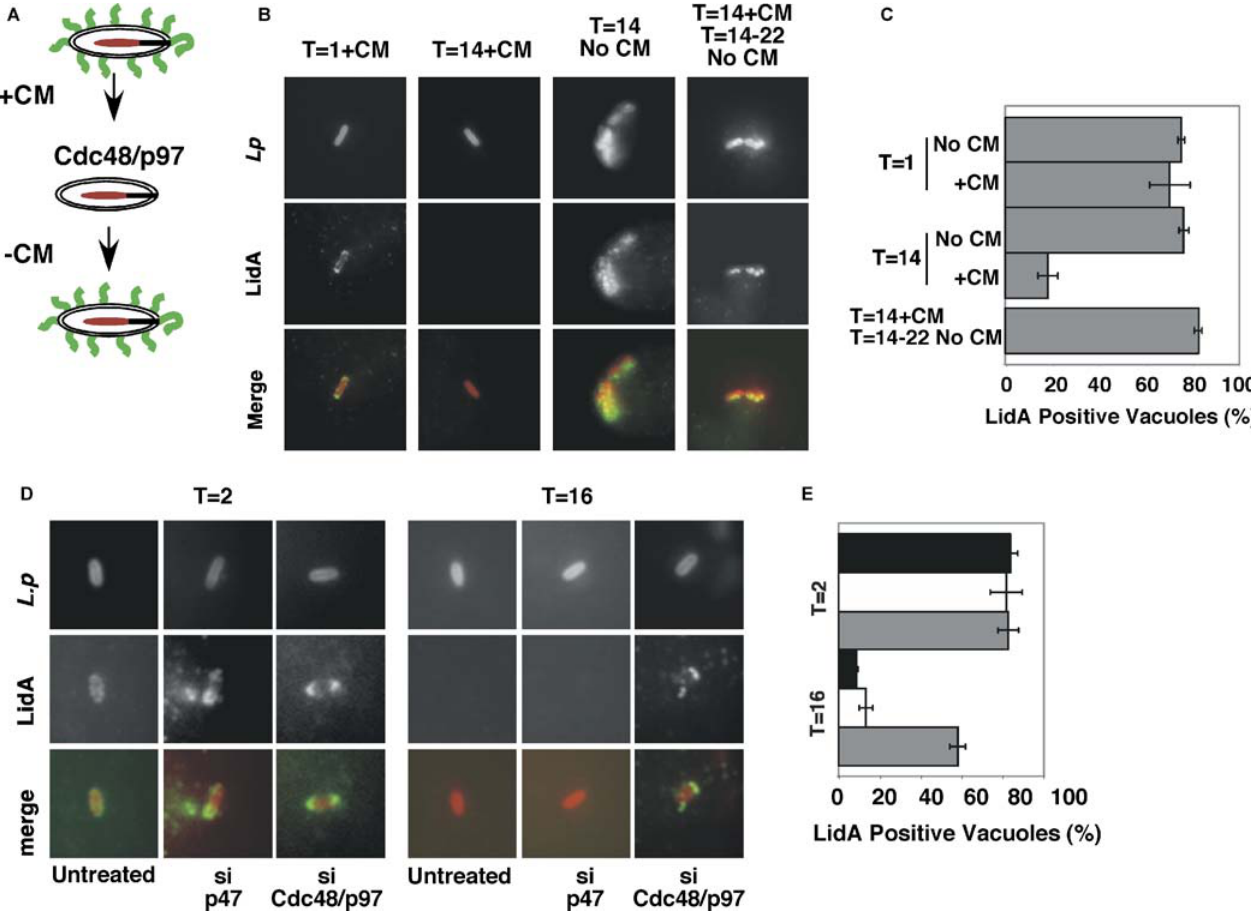
(A) Cdc48/p97 mediates the removal of LidA (green) from the LCV (red) during incubation with CM. (B) Mouse BMDMs were incubated with L. pneumophila at MOI ¼ 1 for 1 h in CM, washed, and fixed, or further incubated in CM as indicated. Cells were immunostained with anti-LidA and anti– L. pneumophila. (C) Quantification of LidA-positive vacuoles from (B), showing mean of three replicates 6 standard error; at least 100 cells counted per